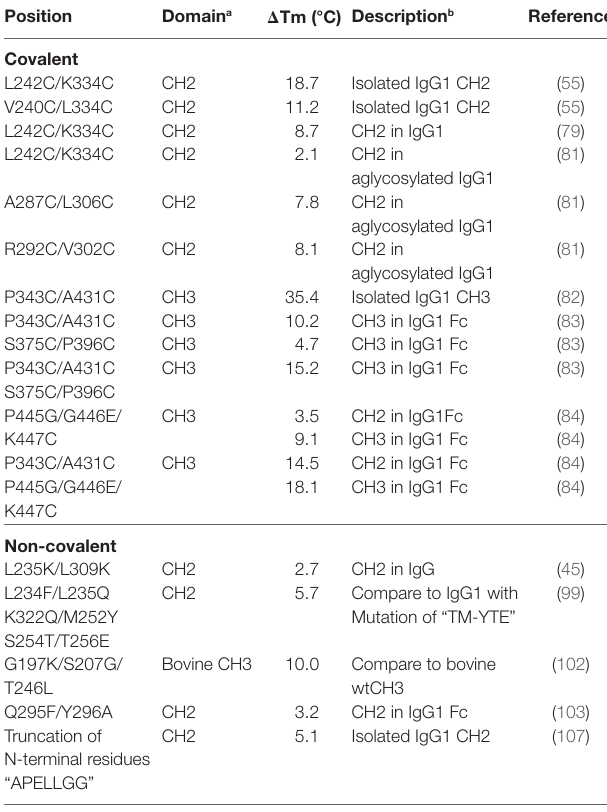
TABLe 1 | Introduction of disulfide bonds and engineering of non-covalent interactions in CH2 and CH3